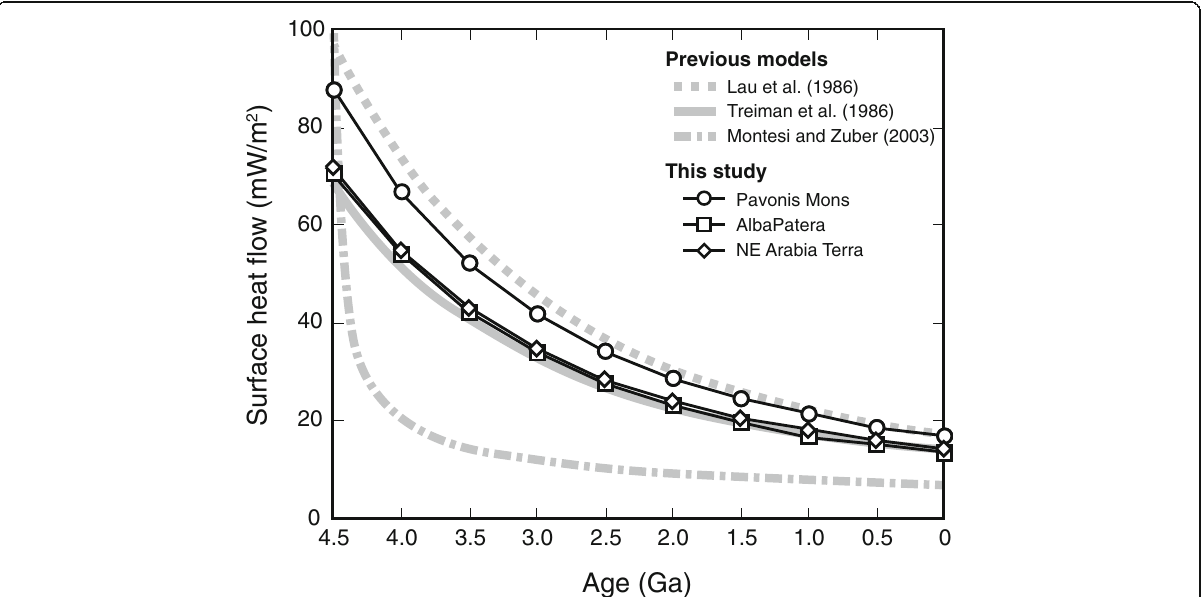
Fig. 3 Calculated surface heat flow at Pavonis Mons, Alba Patera, and NE Arabia Terra during the geological history. The grey lines indicate heat fluxes estimated using different chemical and cooling models (Montesi and Zuber 2003). Nimmo and Tanaka (2005) presented a chemical evolution model, resulted in the averaged surface heat flow of 14.3 mW/m 2 for the present day and 63.4 mW/m 2 for 4.1 Ga